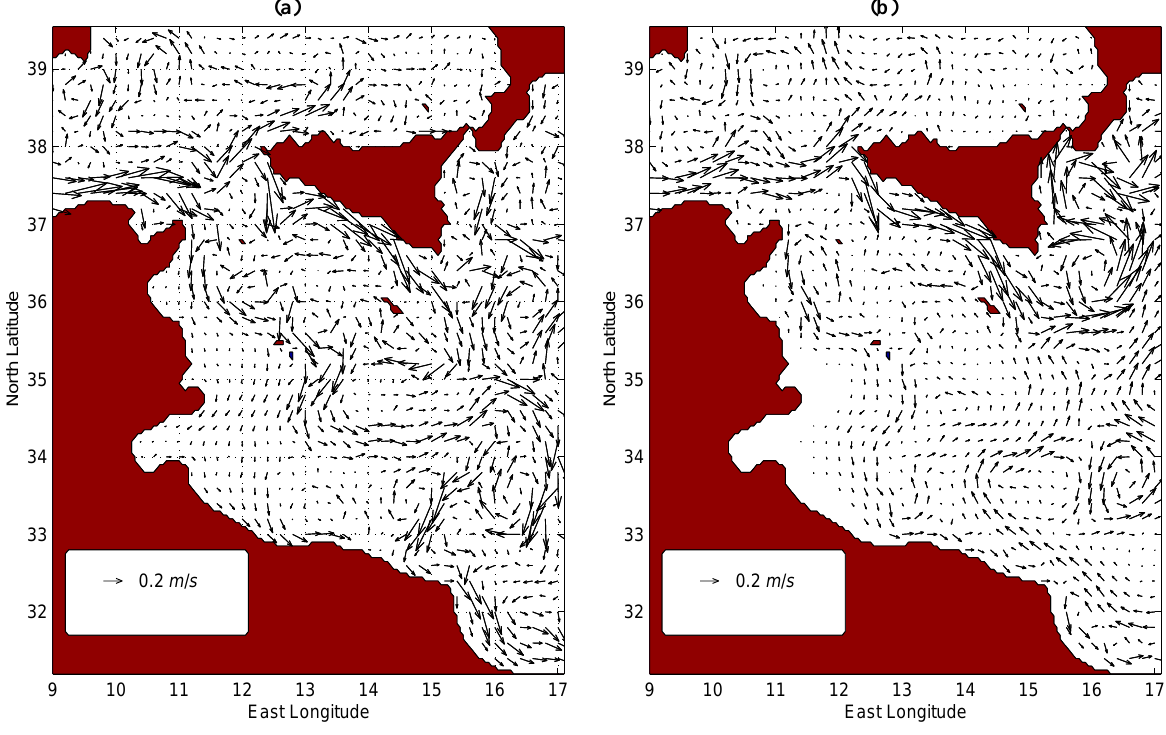
Fig. 13. The simulated 10-day averaged total velocity field at 5m depth in (a) February and (b) August. One vector every four grid points is plotted. Units are